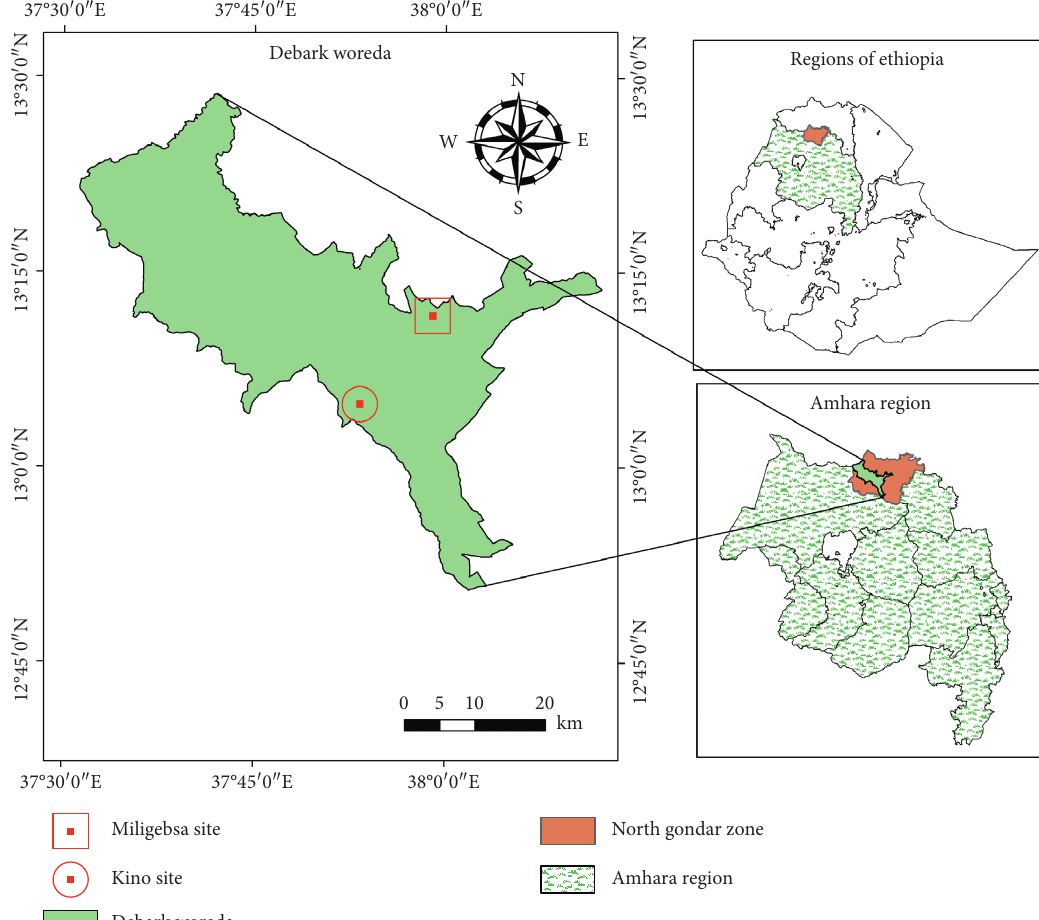
Figure 1: Map of the study area: Amhara National Regional State in Ethiopia, north Gondar in Amhara region, Debark district in north Gondar, Kino and Miligebsa Keble in Debark